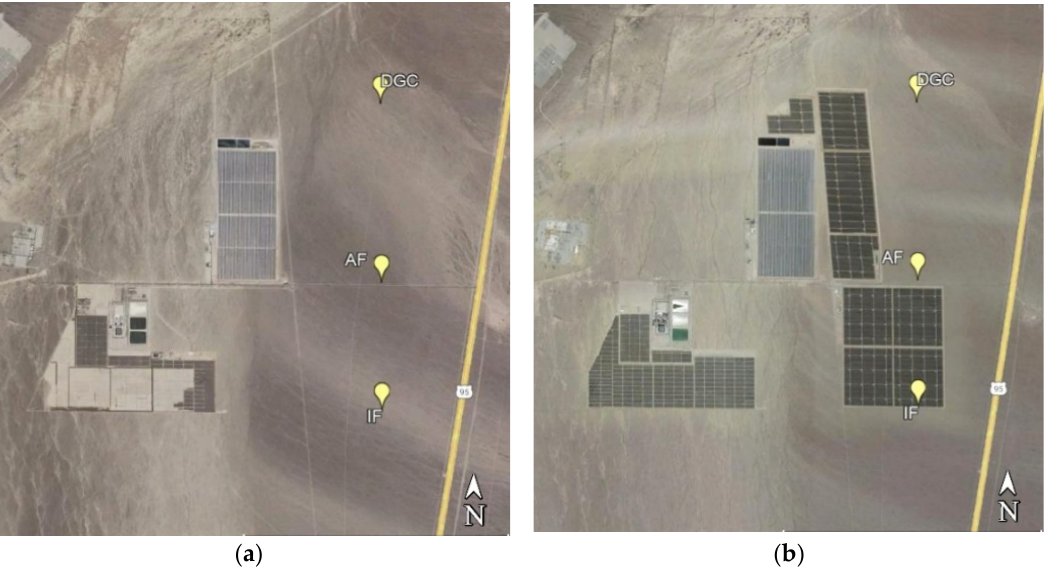
Figure 1. Site location map. Google Earth images of the study area in 2010 ( a ) and 2015 ( b ). 10 m meteorological towers were placed at the site in 2015 and are indicated with yellow thumbtacks; IF = Inside facility, AF = Adjacent to Facility and DGC = Down gradient Control.